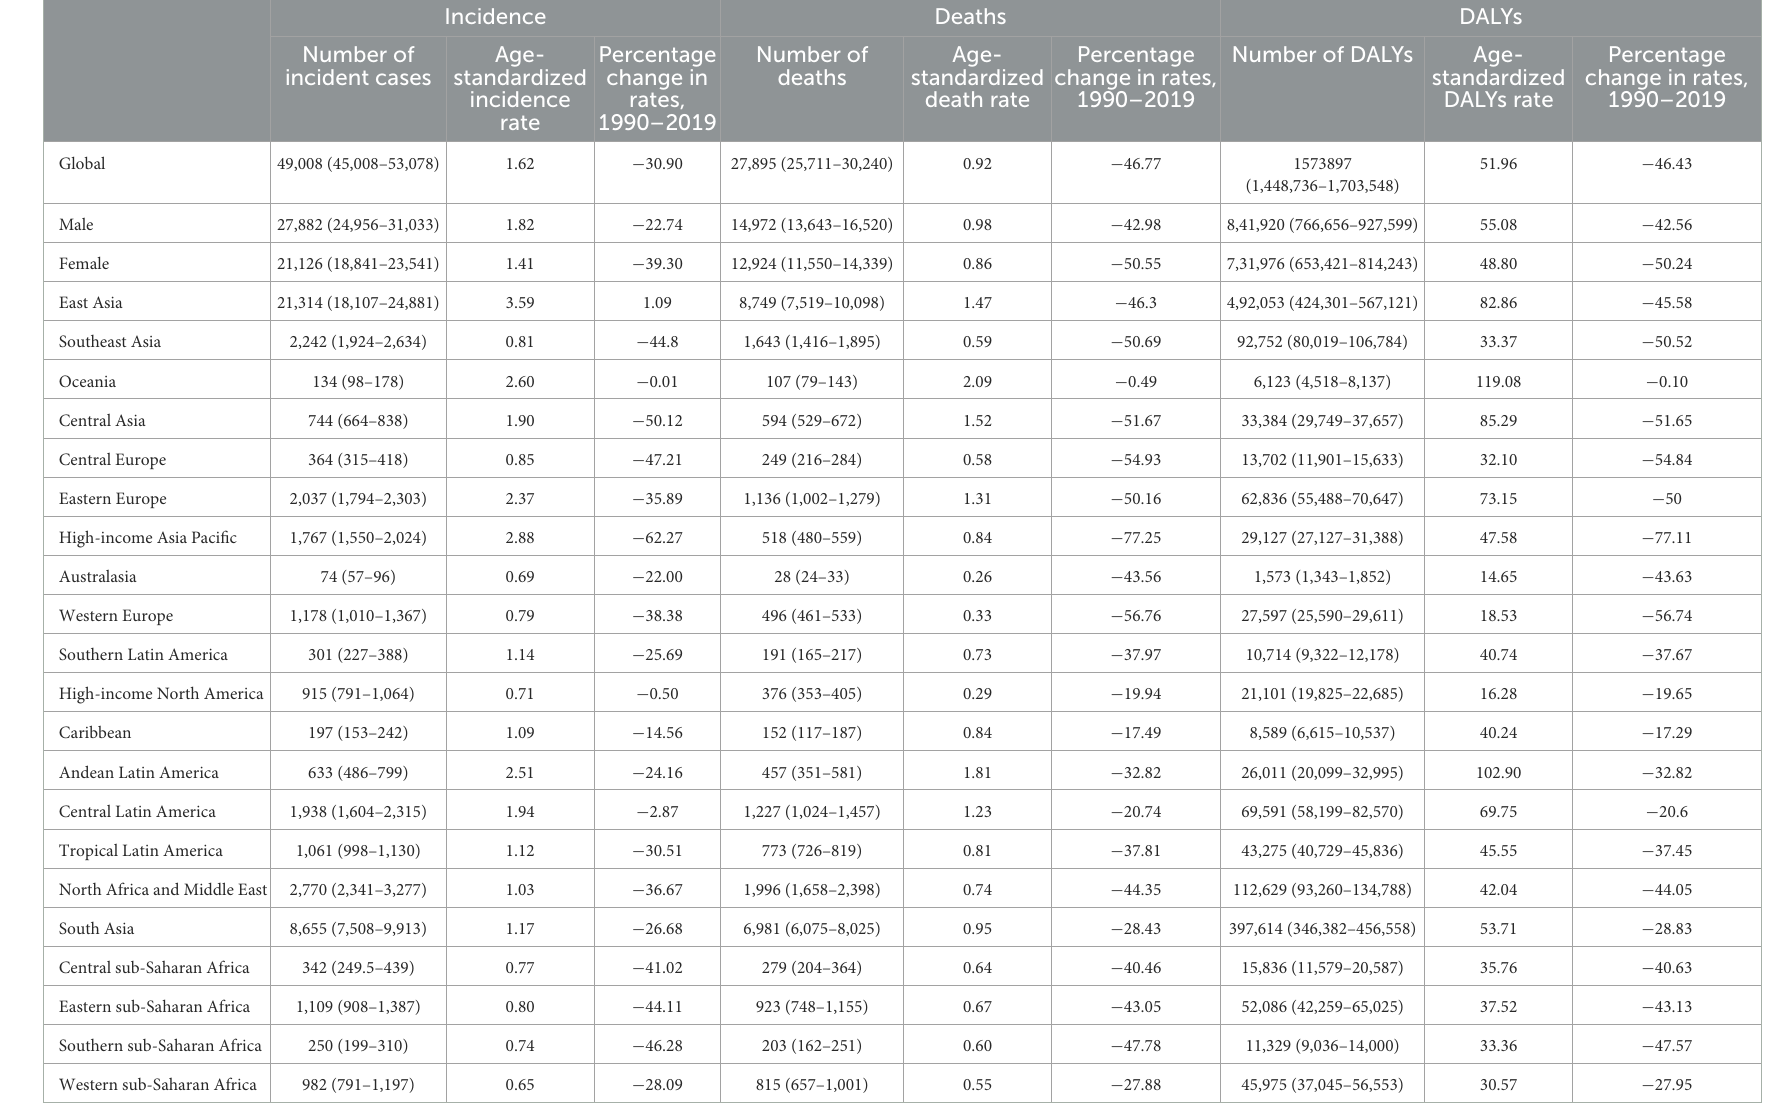
TABLE 1 Incident cases, deaths, and DALYs of AYA stomach cancer in 2019, and percentage change of age-standardized rates by sex and GBD